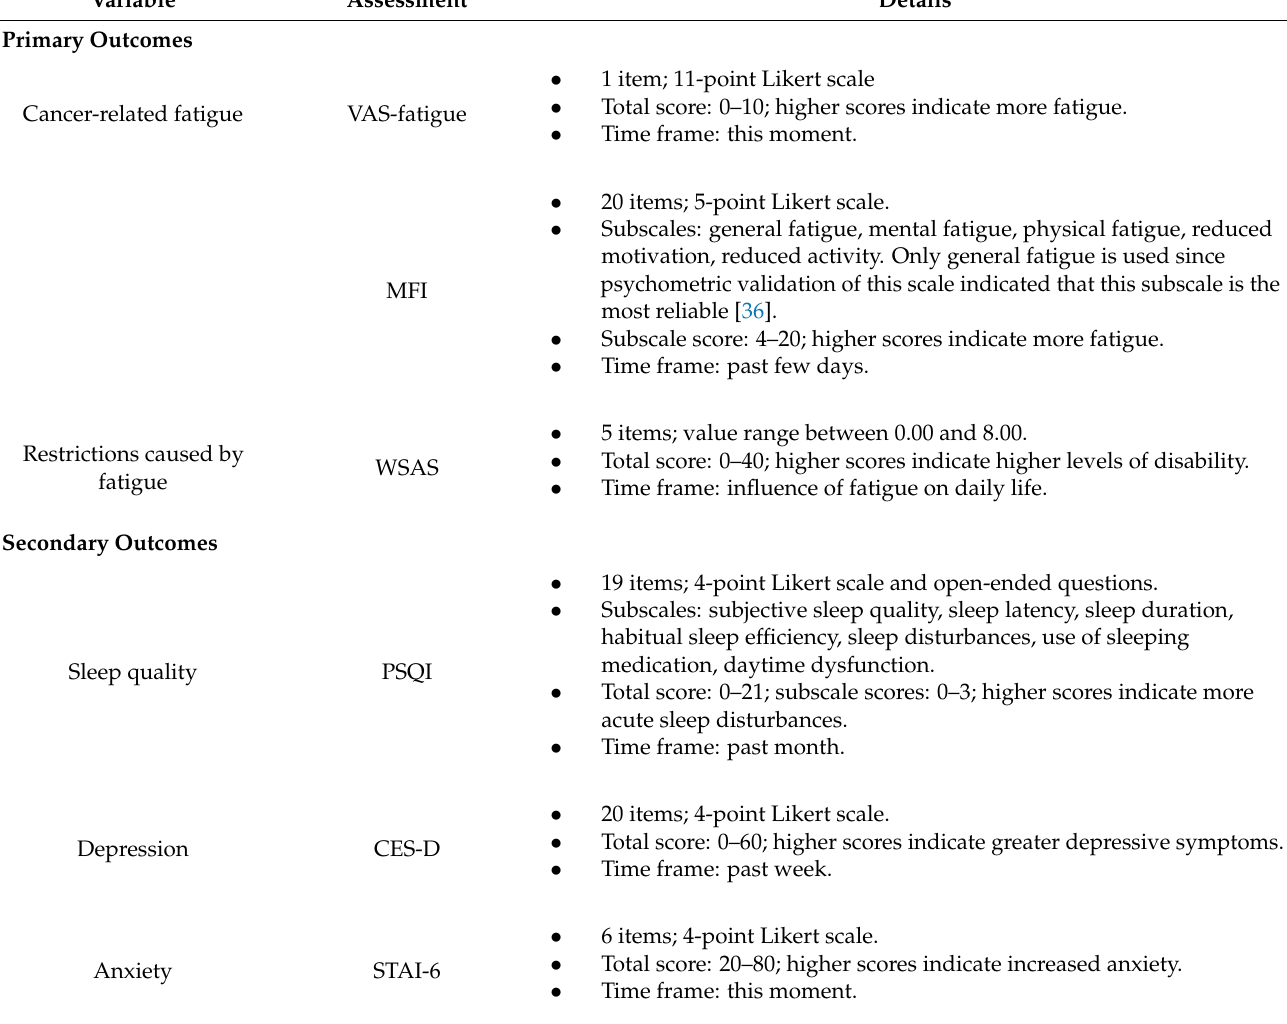
Table 1. Study outcome measures and corresponding